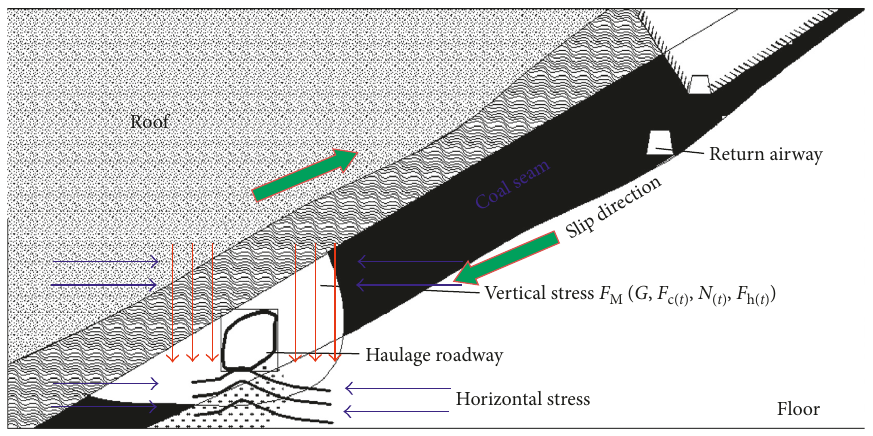
Figure 7: Load diagram of haulage roadway in coal mining